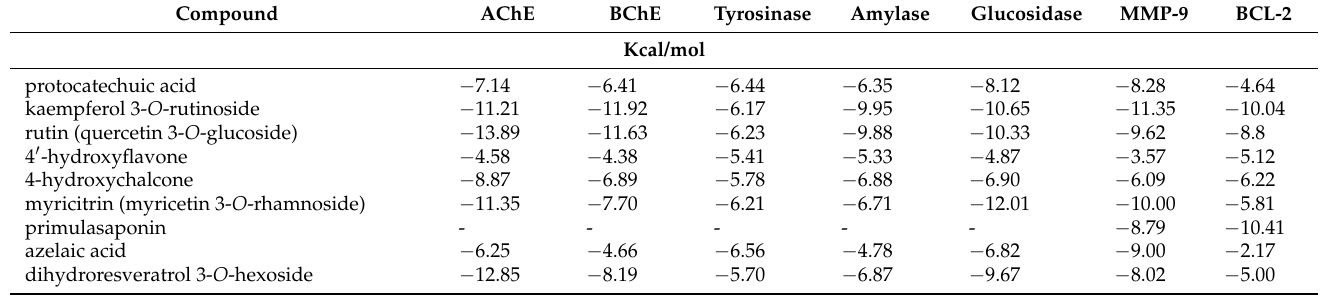
Table 5. Calculated binding energy values of extracted compounds from P. auriculata against protein targets, including cancer proteins (MMP-9 and BCL-2).